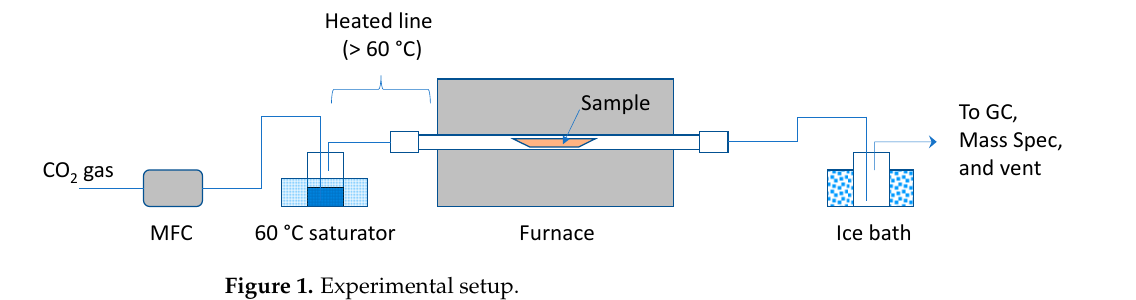
Figure 1. Experimental setup.